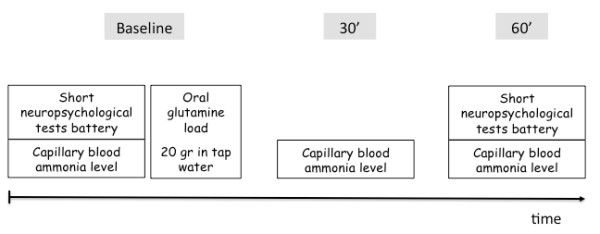
Design of the study.